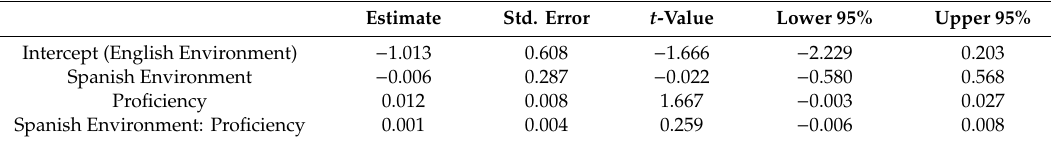
Table 5. Global Accent Rating Model with Proficiency Fixed Effects.